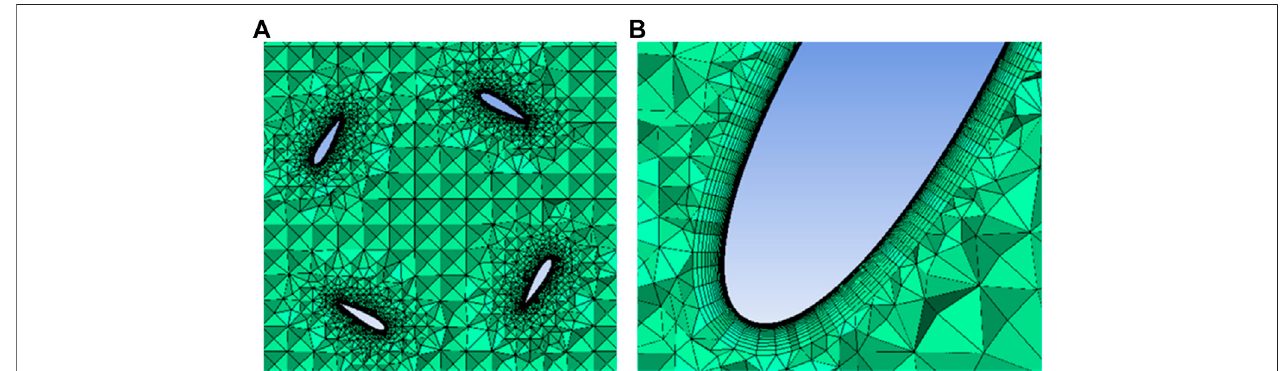
FIGURE 3 | Grids around airfoil.